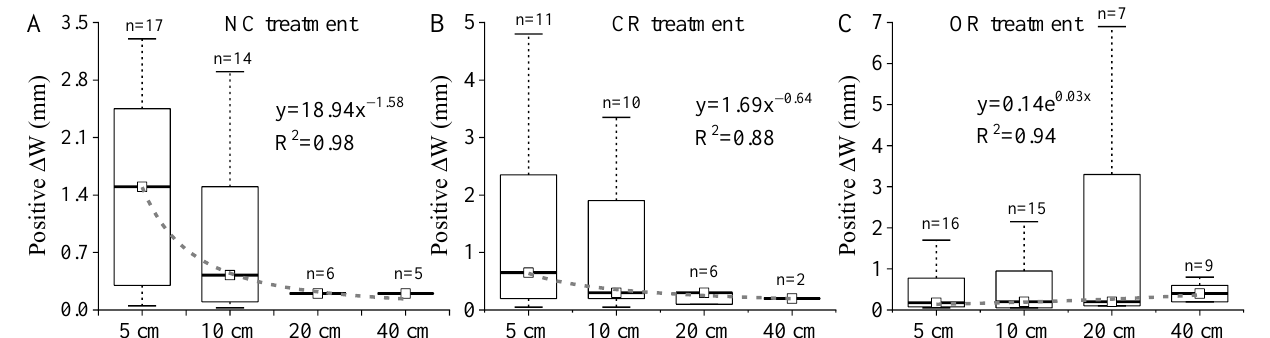
Figure 7. The positive ∆ W on rainy days at different depths in different treatments. ( A – C ) represent the NC, CR, and OR treatments, respectively. A positive ∆ W means an increase in W induced by precipitation on rainy days. NC: natural condition, CR: canopy + roots, OR: only roots. The gray dashed lines are the fitting curves for the median value of positive ∆ W at different depths.